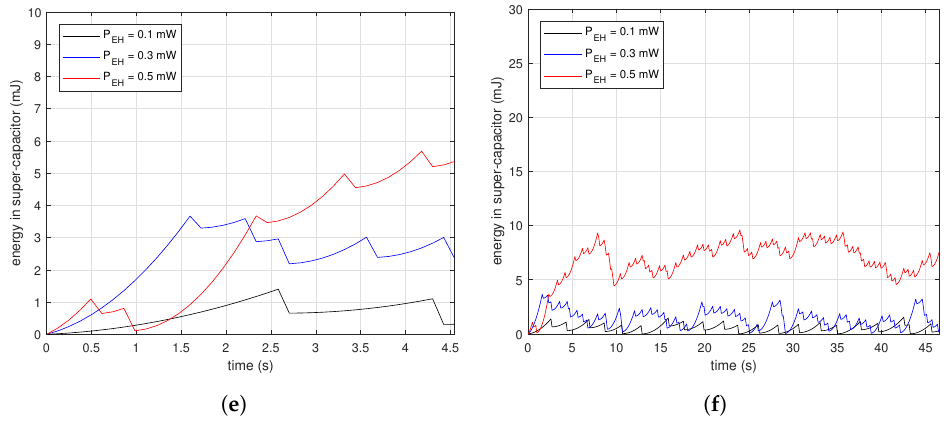
Figure 7. Initial amount of stored energy in a super-capacitor in conditions of N BI = 1, N BI = 4, and N BI = 8: ( a ) From 0 to 4.5 s for N BI = 1; ( b ) From 0 to 47 s for N BI = 1; ( c ) From 0 to 4.5 s for N BI = 4; ( d ) From 0 to 47 s for N BI = 4; ( e ) From 0 to 4.5 s for N BI = 8; ( f ) From 0 to 47 s for N BI = 8.